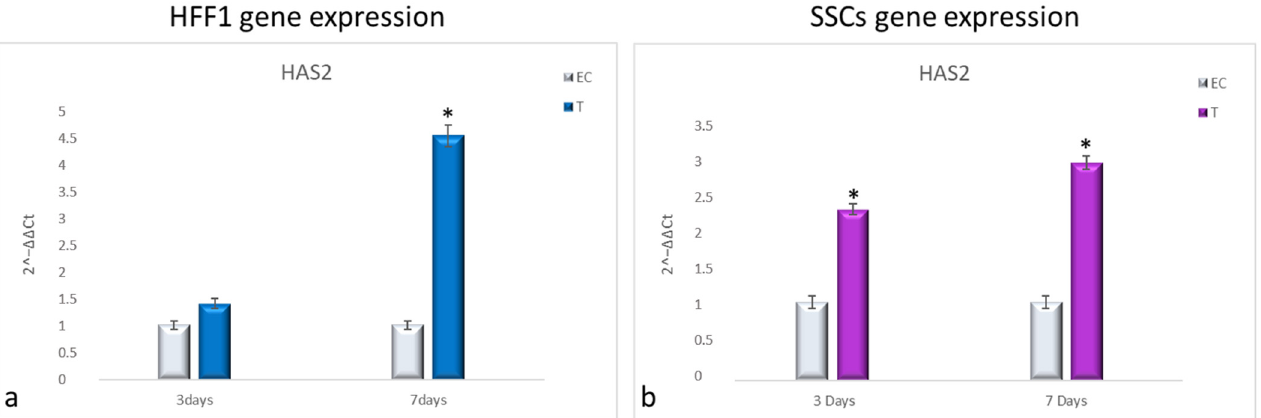
Figure 5. Gene expression analysis of SIRT1 and SIRT2 in SSCs ( a , b ). SSCs were exposed to the different culturing conditions. mRNA levels of SIRT1 ( a ) and SIRT2 ( b ) in EC (grey bars) and T (colored bars) are expressed as fold change (2 −∆∆ ct ) compared with negative controls (UnC = 1). EC and T cells were exposed to UV light for 2 min at 10 cm distance from the lamp to induce oxidative stress. UnC samples were not exposed to UV light and not pre-treated with NanoPCL-M (UnC = 1). T samples were pre-treated with NanoPCL-M before UV stress exposure. * p ≤ 0.05. NanoPCL-M pre-treatment induced the overexpression of HAS2 compared with EC in both HFF1 and SSCs along with all the culturing period (Figure 6a,b, respectively).